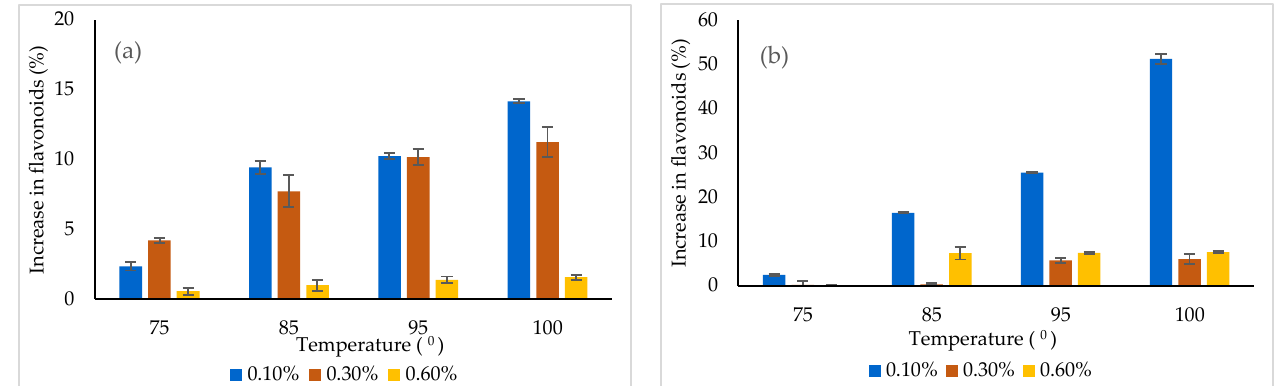
Figure 5. The effect of thermal treatment on the flavonoids released from the powders ( a ) variant 1, ( b ) variant 2. The flavonoids’ release from the powders was found to be temperature and concen- tration dependent. In variant 1, the highest release of approximately 14% was found at 0.1% and 100 °C, whereas in variant 2, a significantly higher release of 51% was high- lighted under similar conditions. Therefore, it could be understood that variant 2 was less protective when a thermal treatment was applied.